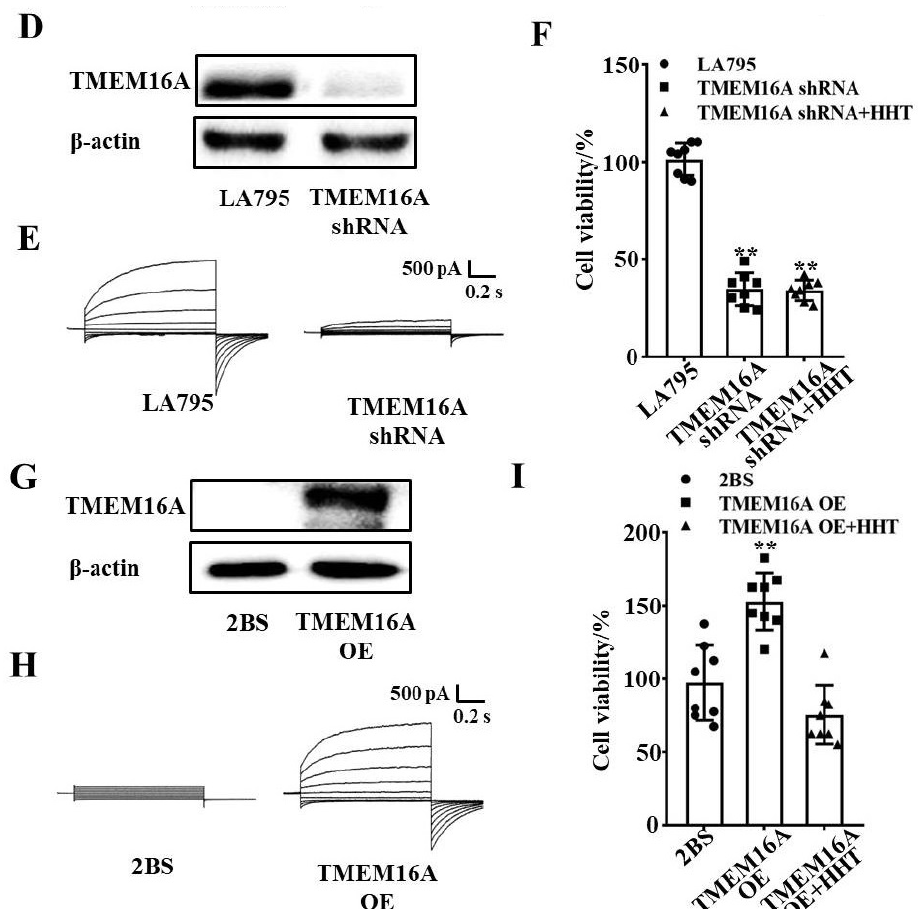
Figure 4. HHT inhibited lung cancer cell proliferation through inhibited TMEM16A. ( A ) TMEM16A protein expression treated with different concentrations of HHT for 24 h. ( B , C ) Inhibitory effect of HHT to the proliferation of LA795 and 2BS cells with different concentrations ( n = 8). ( D ) Expression of TMEM16A protein in LA795 cells before and after shRNA transfection ( n = 3, ** p < 0.01). ( E ) Typical whole-cell currents of TMEM16A in LA795 cells before and after shRNA transfection ( n = 5). ( F ) Cell viability of LA795 cells before and after shRNA transfection ( n = 8, ** p < 0.01). ( G ) Expression of TMEM16A protein in 2BS cells before and after TMEM16A transfection ( n = 3). ( H ) Typical whole-cell currents of TMEM16A in 2BS cells before and after TMEM16A transfection ( n = 5). ( I ) Cell viability of 2BS cells before and after TMEM16A transfection ( n = 8, ** p < 0.01). 3.5. TMEM16A Is a Potential Drug Target of HHT That Inhibits Lung Cancer Cell Migration Wound healing experiments were performed to test the inhibitory effects of HHT on LA795 cell migration. Figure 5A shows that the inhibitory effects of HHT against LA795 cell migration are more evident as the concentration of HHT increases. In addition, the inhibitory rates of the same concentration of HHT on LA795 cell migration increased with time. Therefore, the inhibitory effect of HHT on LA795 cells was observed to be concentration- and time-dependent (Figure 5B). Next, the migration of LA795 cells was significantly reduced after the endogenous TMEM16A was knocked down by shRNA (Figure 5C). In addition, HHT did not inhibit the migration of LA795 cells transfected with TMEM16A shRNA (Figure 5D). Correspondingly, overexpression of TMEM16A in 2BS cells obviously improved cell migration, which could be inhibited by HHT (Figure 5E,F). These findings prove that TMEM16A is a drug target of HHT, which inhibited LA795 cell